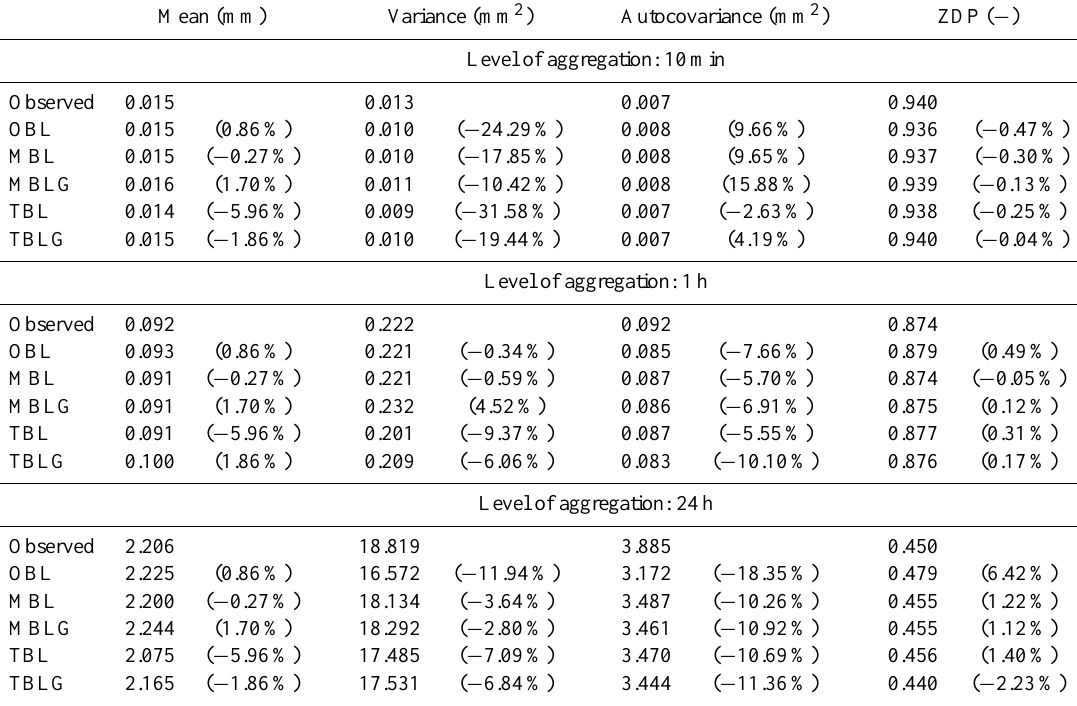
Table 3. Comparison of general historical rainfall characteristics with simulation results. Values between brackets are percentage deviations of the simulated characteristic with respect to the